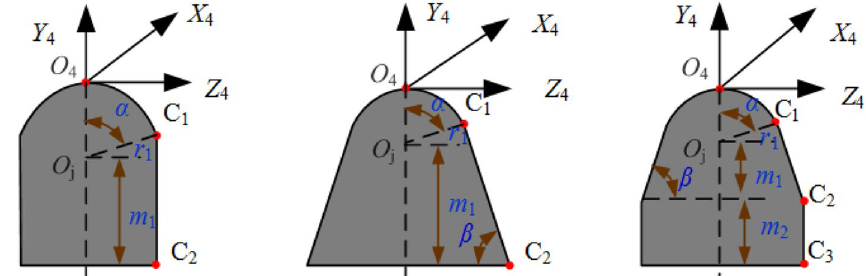
Figure 3. Type and coordinate definition of cutting head.